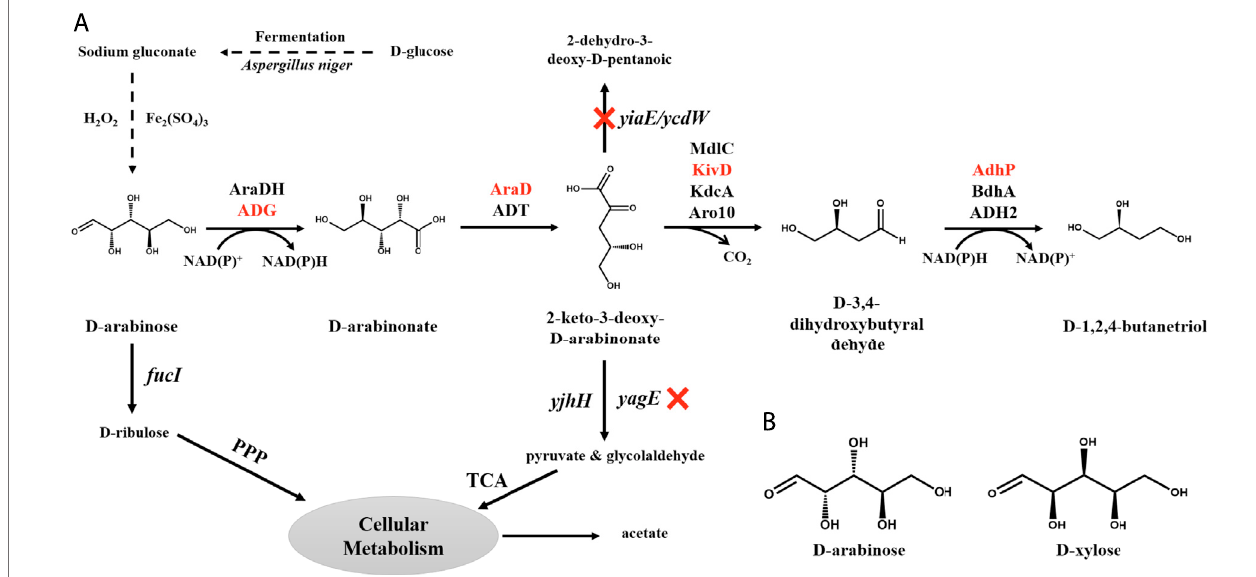
FIGURE 1 | The BT biosynthetic pathway from D -arabinose in recombinant E. coli . (A) The dashed lines represent the synthetic method from D -glucose to D -arabinose.ThesyntheticpathwayofBTandbranchpathwaysaremarkedbysolidlines.TheredXsindicatethatthegenesareknockedoutandenzymesshowninred indicate that these enzymes have been chosen for the production of BT from D -arabinose after screening. Symbols: AraDH/ADG, D -arabinose dehydrogenase; AraD/ ADT, D -arabinonate dehydratase; MdlC/KivD/KdcA/Aro10, 2-keto acid decarboxylase; AdhP/BdhA/ADH2, aldehyde reductase; fucI encoding L -fucose isomerase; yiaE / ycdW encoding glyoxylate reductase; yagE / yjhH encoding 2-keto-3-deoxy- D -arabinonate aldolase; PPP, pentose phosphate pathway; TCA, tricarboxylic acid cycle. (B) The structure of D -arabinose and D